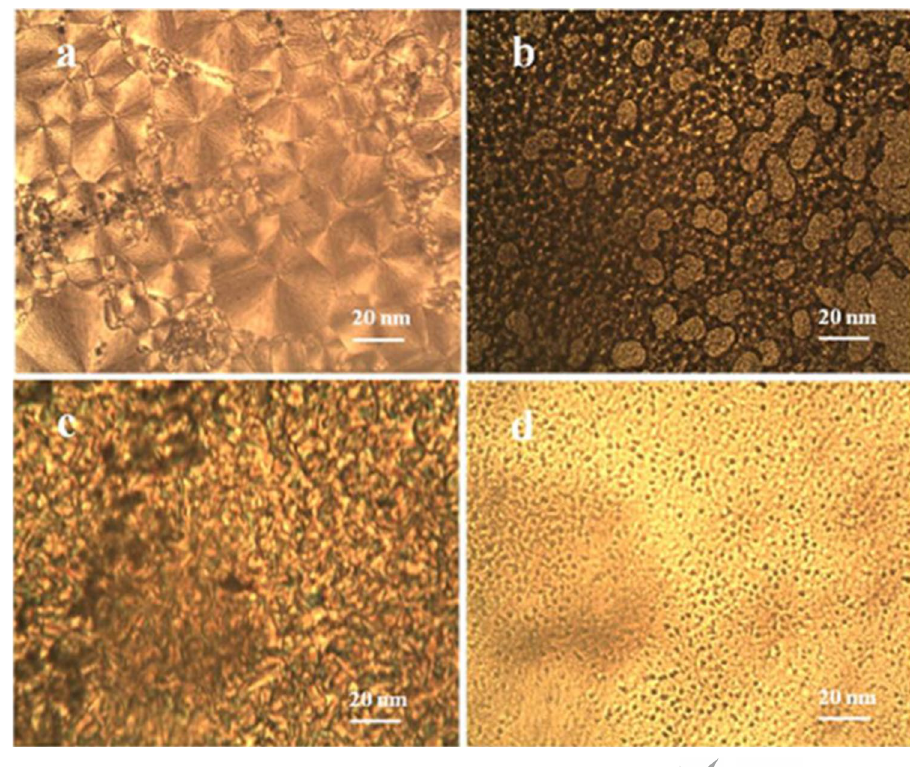
Fig. 6 POM micrographs of a and d 30 wt% ZnO/nylon